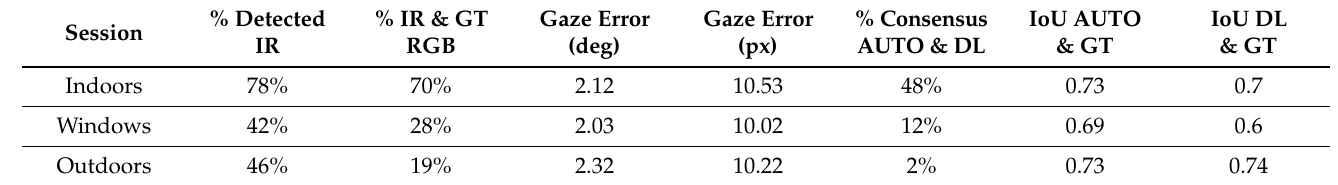
Table 2. Summary of results for valid sessions. In addition to gaze error metrics, we calculated: (1) percentage of consensus ( IoU > 0.5) between computed pupils’ bounding rectangle by automatic transformation from IR, and the ground truth (manually labeled) in the RGB images; (2) the IoU between computed pupils’ bounding rectangle by automatic transformation from the IR images, and the ground truth in the RGB images; (3) the IoU between bounding rectangle computed by the deep learning algorithm in the RGB images, and the ground truth in the RGB